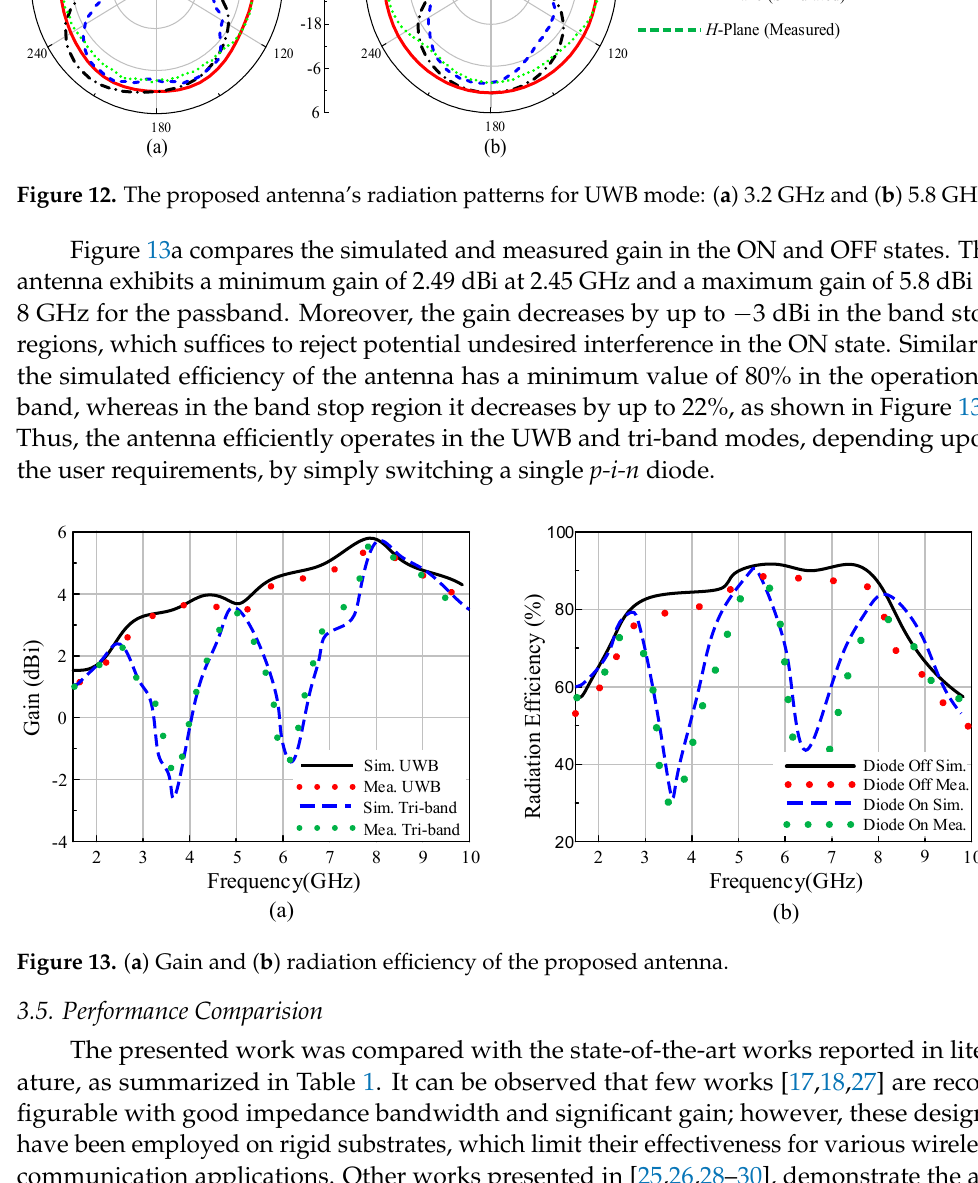
GHz, and ( c ) 8 GHz.